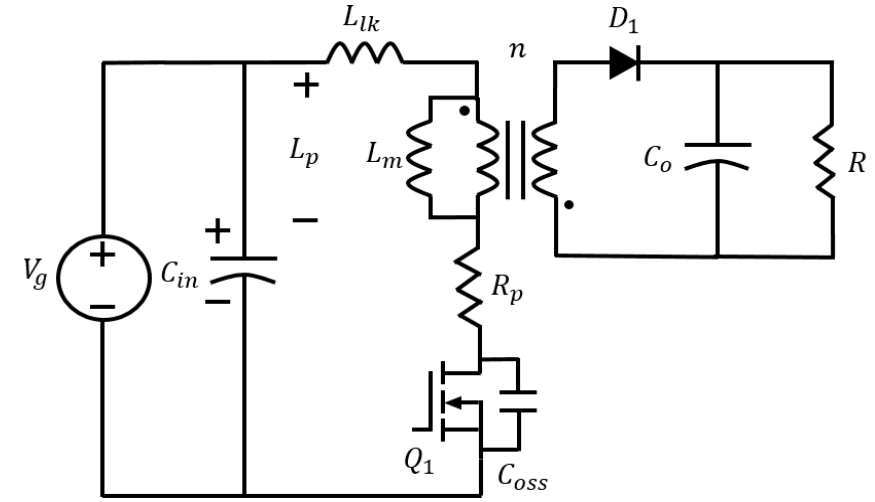
Figure 1. Fly-back converter circuit.